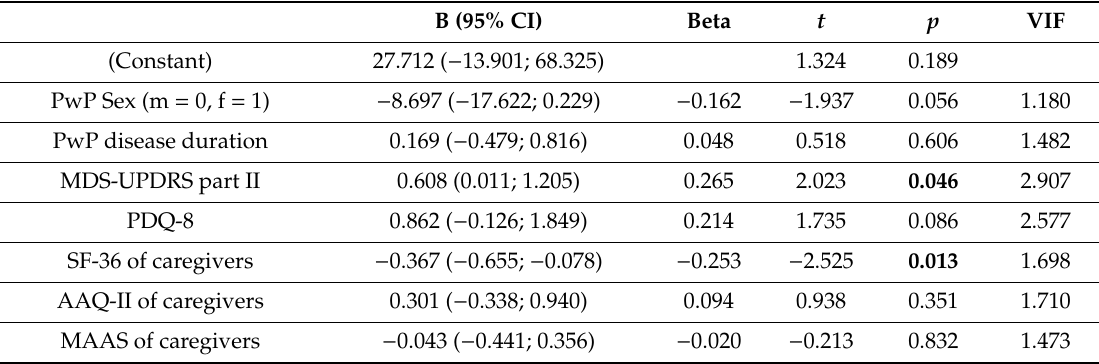
Table 3. Multiple regression analysis of significant factors associated with caregiver burden measured by PDCB in linear regression